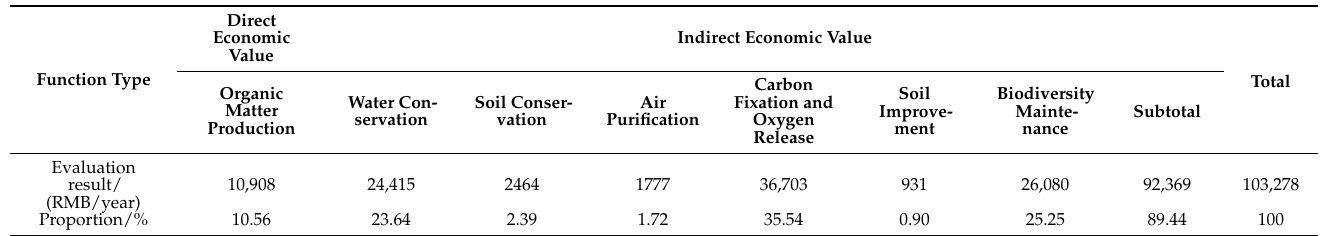
Table 10. Value of various ecological functions of Liquidambar formosana plantation ecosystem.